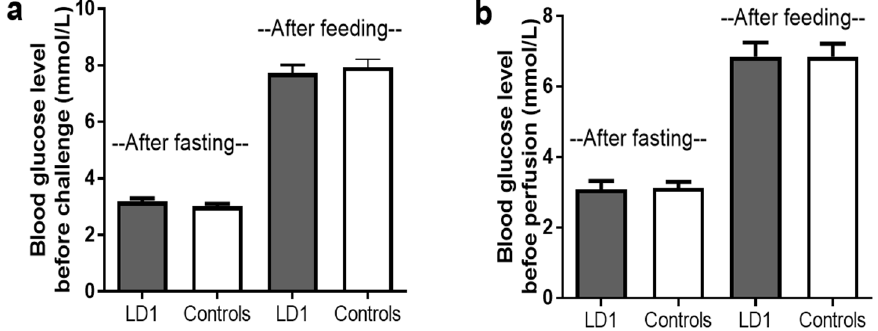
Figure 5. Blood glucose levels of mice were monitored while fasting (no food given overnight) and 2